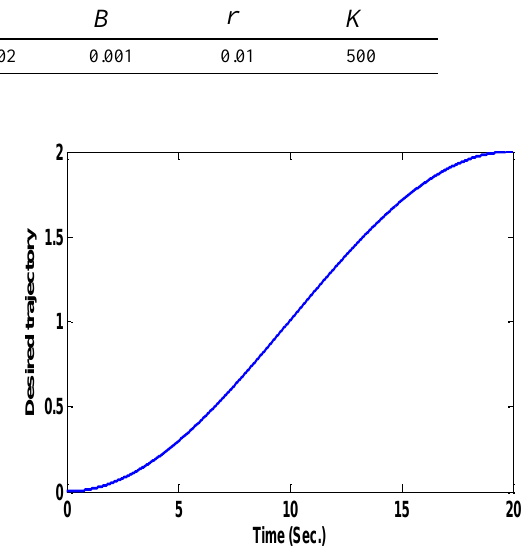
Figure 3. Desired trajectory for joints 1 and